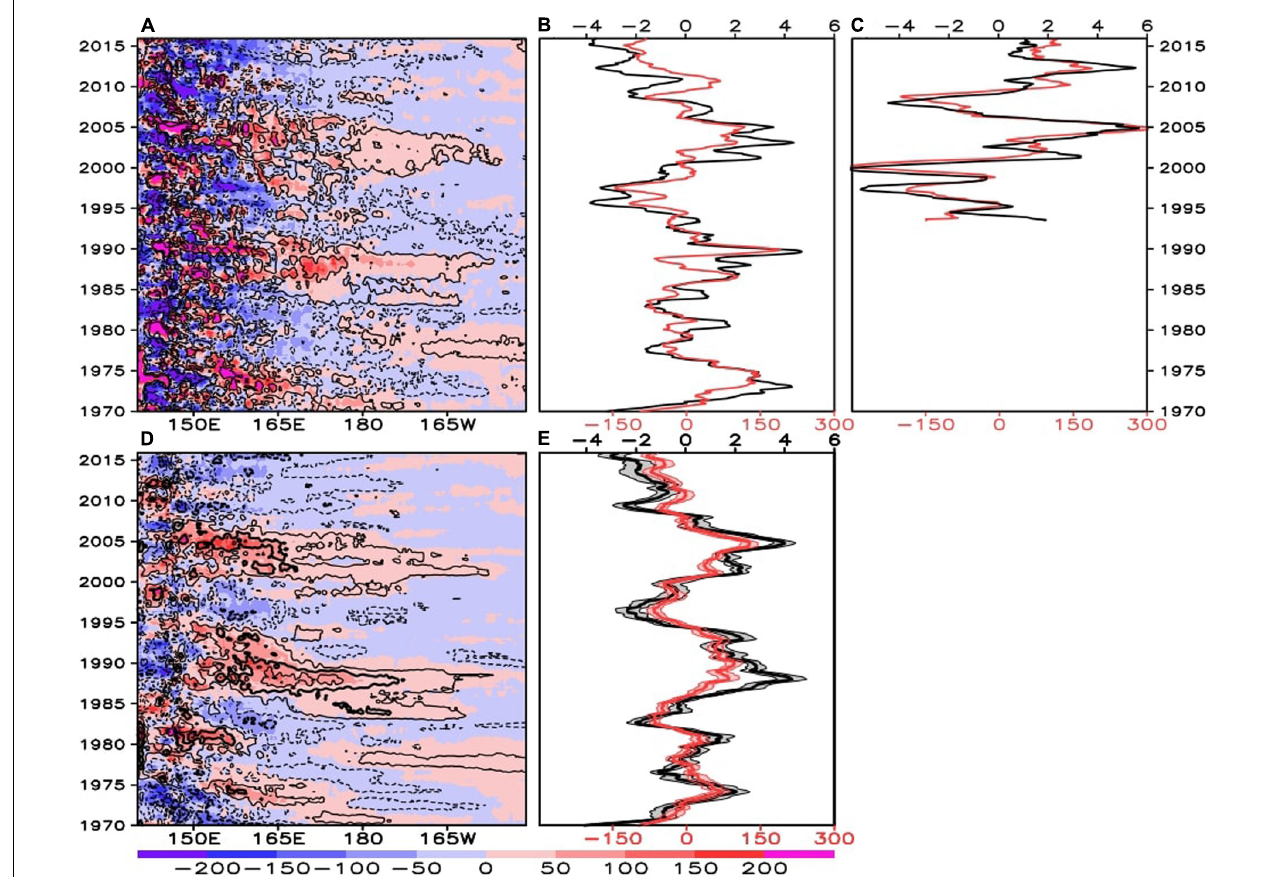
FIGURE 7 | Anomalies of the eddy activity and current speed at 2.5-m-depth meridionally averaged in 32 ◦ –38 ◦ N. (A) Longitude-time section of the eddy activity anomaly (shadings) and current speed anomaly (contours at ± 1, 5 cm s − 1 ). (B) Time series of an individual member EKE (red, bottom axis) and current speed (black, top axis) anomalies averaged in 153 ◦ –165 ◦ E. (A,B) Are for the ensemble member 2, which has the lowest correlation between the two time series among the all ensemble members. (C) Time series of the observed eddy activity (red) and current speed (black) anomalies averaged in 153 ◦ –165 ◦ E. (D) Same as (A) but for the ensemble mean (contours at ± 1, 3, 5 cm s − 1 ). (E) Same as (B) but for the ensemble mean. Shadings indicate the corresponding error bars as ± (ensemble spread/M 1 / 2 ). M = 10, the number of the ensemble members. Unit for current speed is cm s − 1 , for EKE (cm s − 1 ) 2